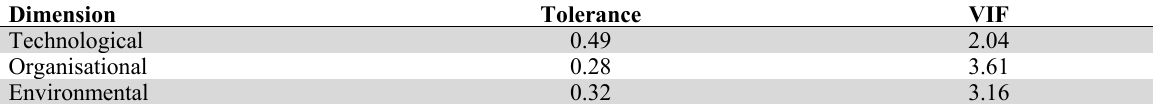
VIF Test and Tolerance of Independent Variable Dimensions Dimension Tolerance